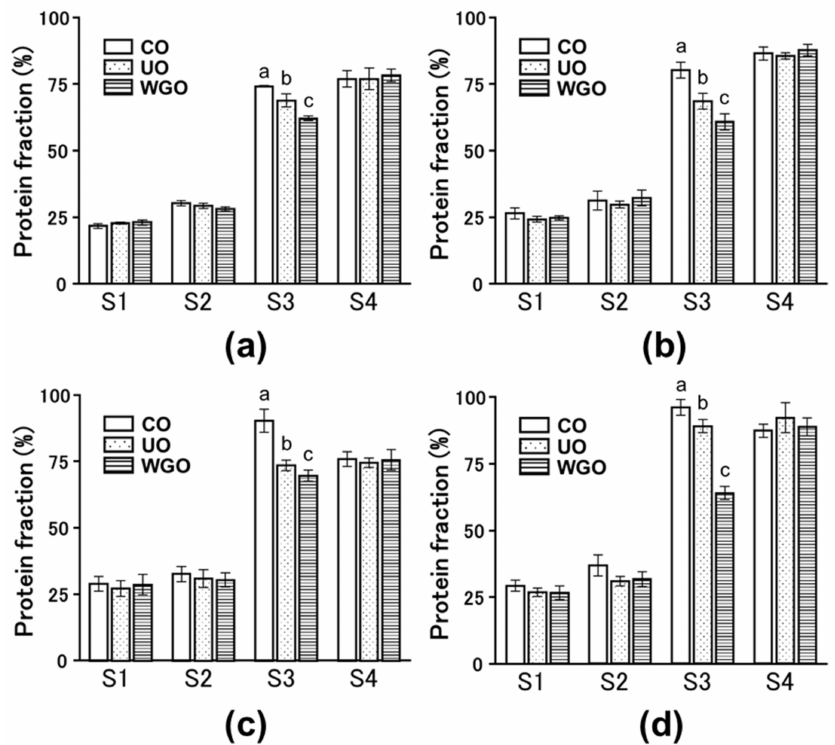
Figure 3. The protein solubility by homogenizing the okara–soybean protein isolate (SPI) gels in the four solutions (S1–S4). ( a ), 3% okara–SPI gels; ( b ), 5% okara–SPI gels; ( c ), 10% okara–SPI gels; ( d ), 15% okara–SPI gels. S1, 0.6 M sodium chloride (NaCl); S2, 0.6 M NaCl and 1.5 M urea; S3, 0.6 M NaCl and 8.0 M urea; S4, 1.0 M sodium hydroxide. CO, control SPI gel; UO, wet grinder